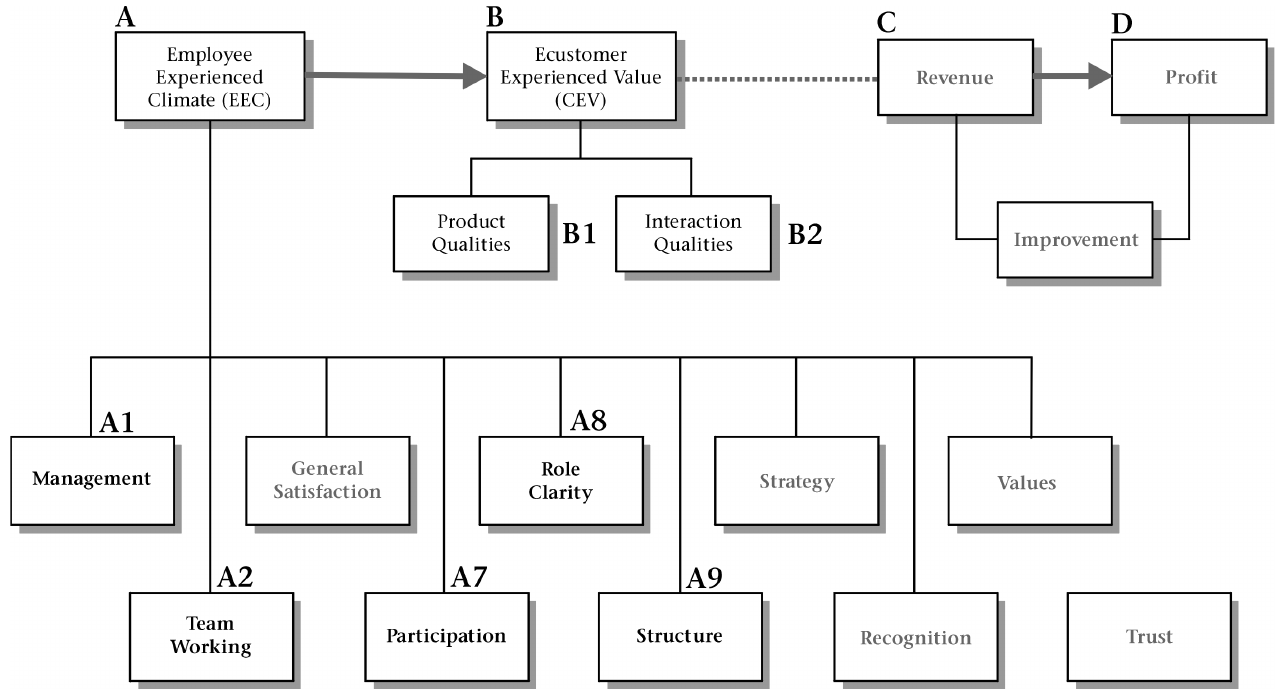
Figure 5: Summary of